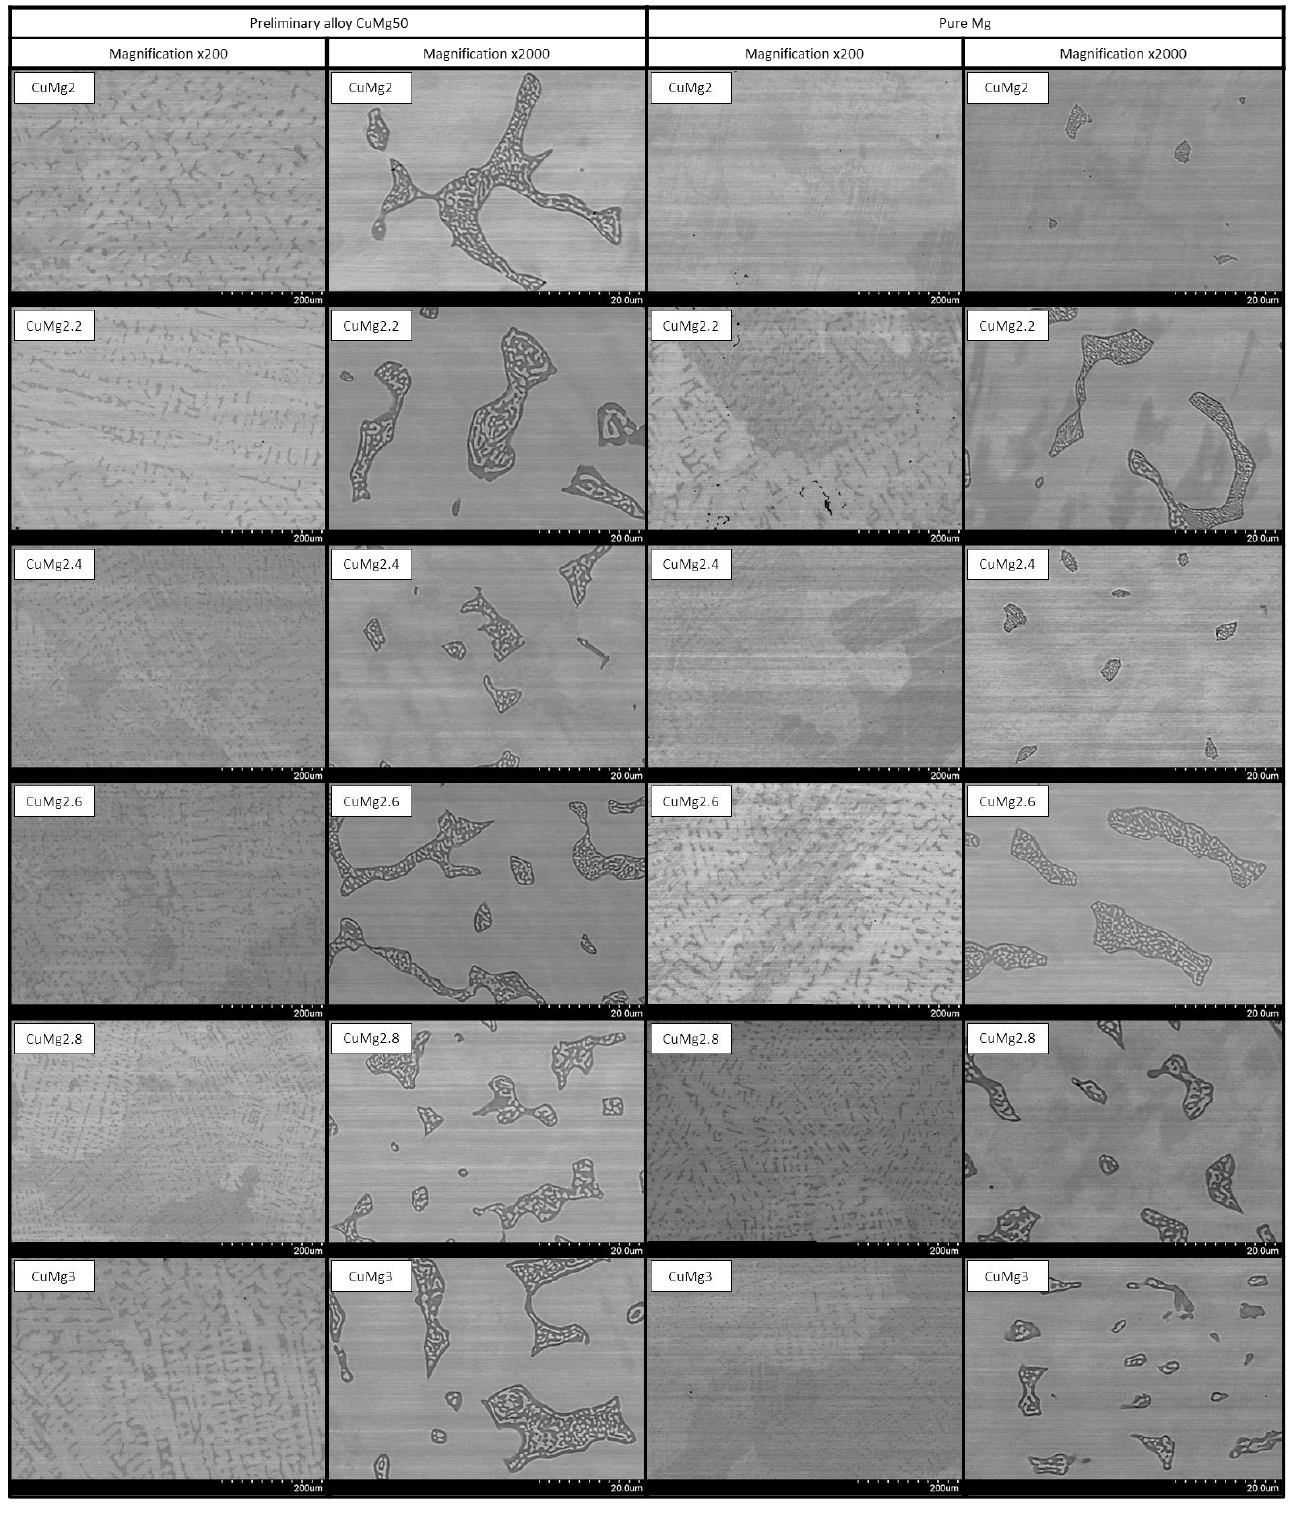
Figure 4. Backscatter electron SEM analysis of CuMg alloys in the as-cast state obtained with preliminary alloy CuMg50 (on the left) and pure Mg (on the right) with two magnifications (200 × on the left and 2000× on the right); the analyzed chemical composition of the alloy is marked on each of the images.